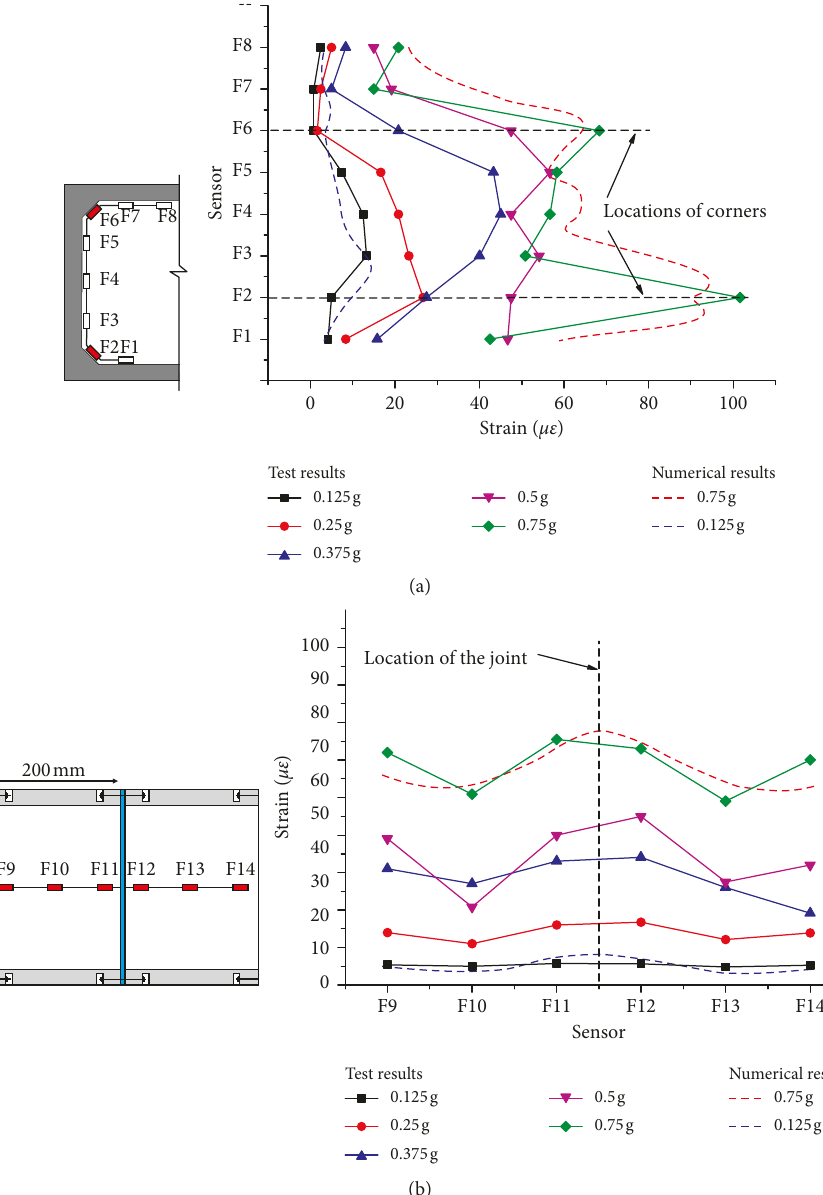
Figure 16: Distribution of structural strain of the utility tunnel: (a) along the cross section; (b) longitudinal